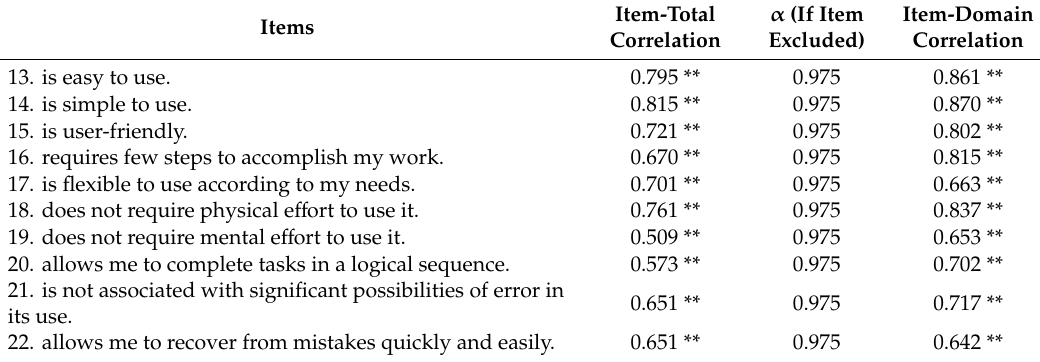
Table 3. Ease of use items (The double-chamber syringe for intravenous therapeutics).